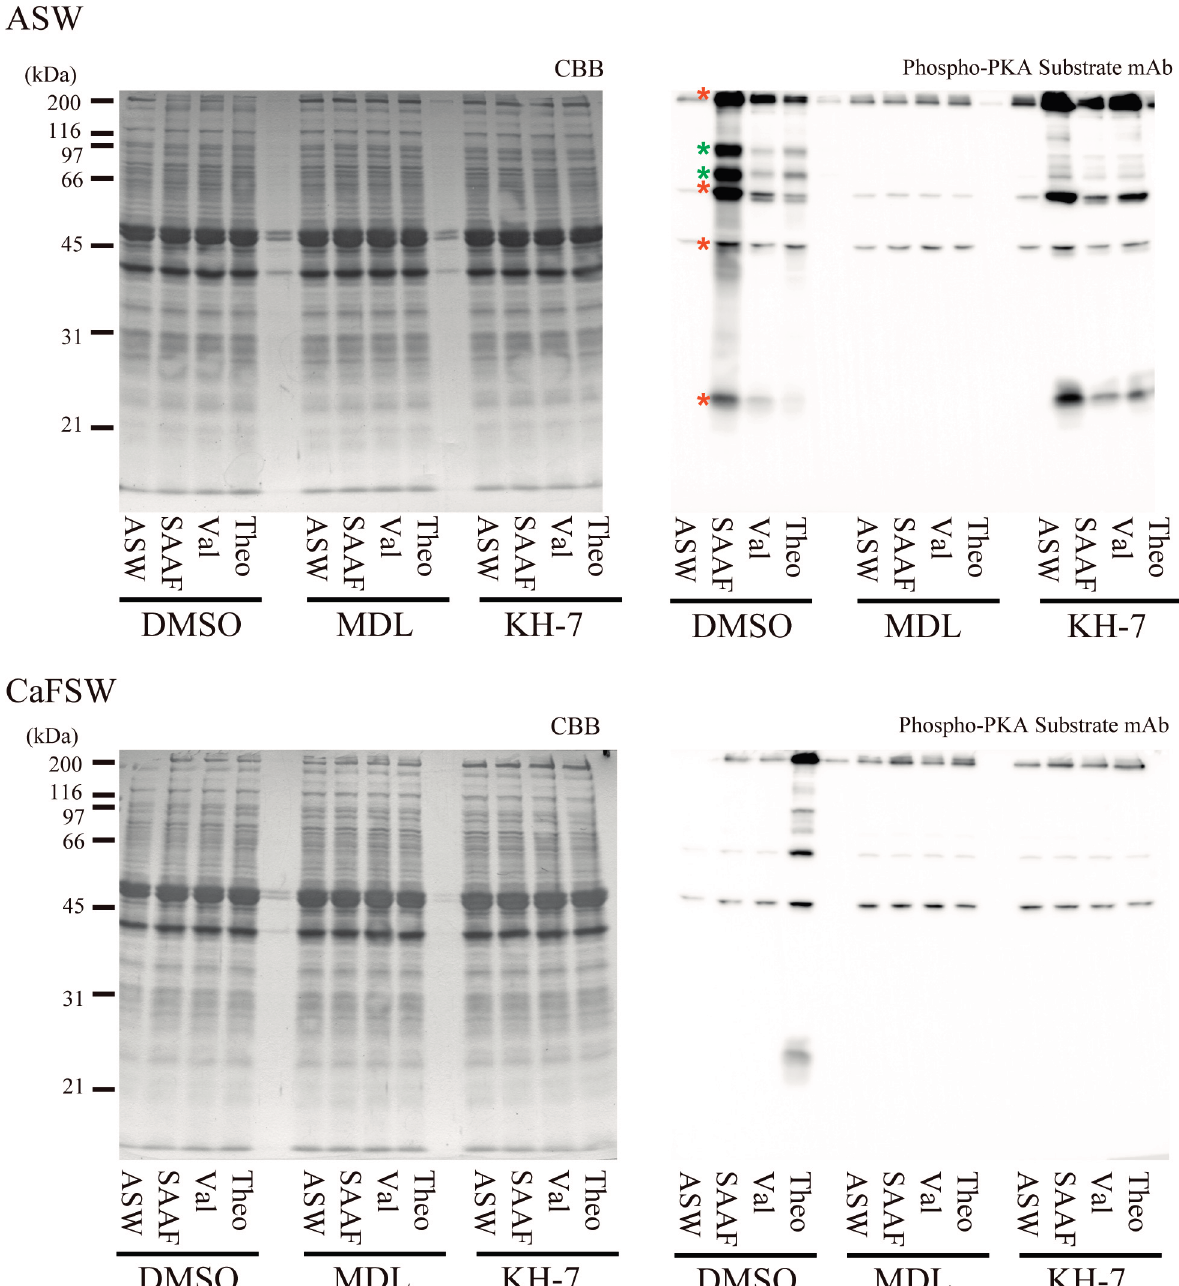
Figure 8. Effects of AC inhibitors on SAAF-, valinomycin (Val)- or theophylline (Theo)-induced protein phosphorylation by protein kinase (PKA). CBB-stained pattern and corresponding western blot with anti-PKA-substrate antibody were shown for sperm treated by artificial seawater (ASW), 100 nM SAAF, 10 nM valinomycin or 1 mM theophylline with 0.5% DMSO (control), 100 μ M MDL12330A or 10 μ M KH-7. Data obtained in ASW ( top ) and in CaFSW ( bottom ) are shown. The percentage of polyacrylamide in the separating gel is 10%. Proteins with significant increase in phosphorylation by SAAF-activation are indicated by asterisks in the lane of sperm sample activated by SAAF in ASW. Those showing decreased phospholylation by KH-7 in ASW are marked in green and others are in red. Data show a typical result from three independent